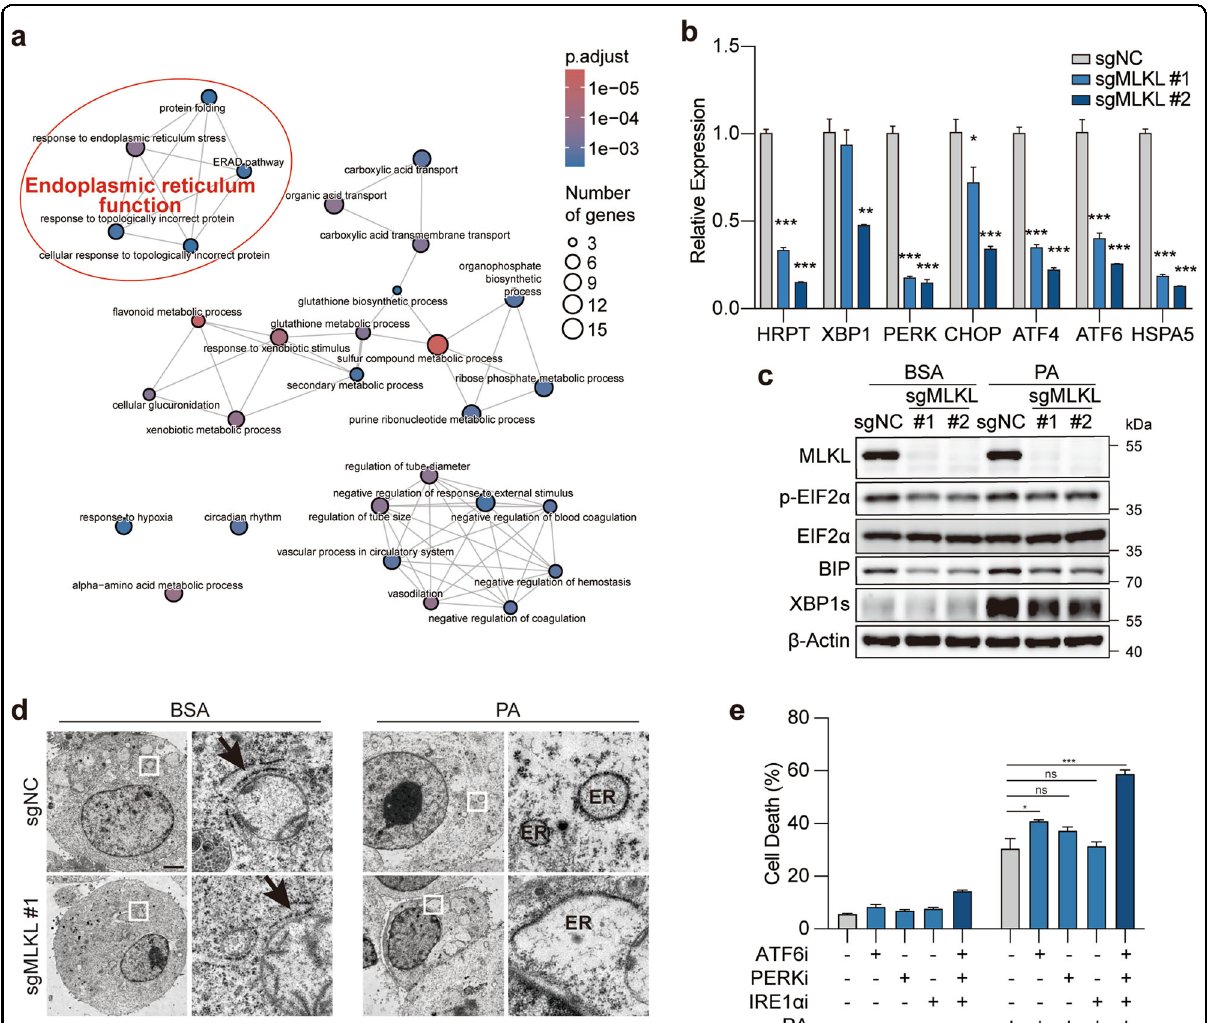
Fig. 4 MLKL de fi ciency leads to ER dysfunction in HCC cells. a GO pathway enrichment analysis. MLKL-KO Hepa 1 – 6-luc (sgMLKL) or control (sgNC) cells were treated with BSA or 0.2 mM PA for 12 h and cells were collected for RNA-seq analysis. b , c mRNA and protein level validation of genes involved in ER stress. MLKL-KO Hepa 1 – 6 and control cells were subjected to qPCR analysis ( b ). Cells treated with BSA or PA (0.2 mM, 12 h) were subjected to immunoblotting analysis ( c ). d Transmission electron microscopy of ER. MLKL-KO Hepa 1 – 6-luc and control cells were treated with BSA or 0.2 mM PA for 4 h. Shown are representative images, scale bar, 200 nm. Arrows indicate ER. e Cell death analysis. Hepa 1 – 6 cells were pretreated with indicated inhibitors for 2 h and then challenged with 0.2 mM PA for 24 h and cell death was analyzed by SYTOX Green assay. Ceapin-A7 as ATF6 inhibitor (ATF6i, 20 μ M), GSK2606414 as PERK inhibitor (PERKi, 20 μ M) and 4 μ 8C as IRE1 α inhibitor (IRE1 α i, 20 μ M). Data are represented as means ± SEM. Two-tailed Student ’ s t -test was used for statistical analysis. ns, not signi fi cant; * P < 0.05, ** P < 0.01, *** P <